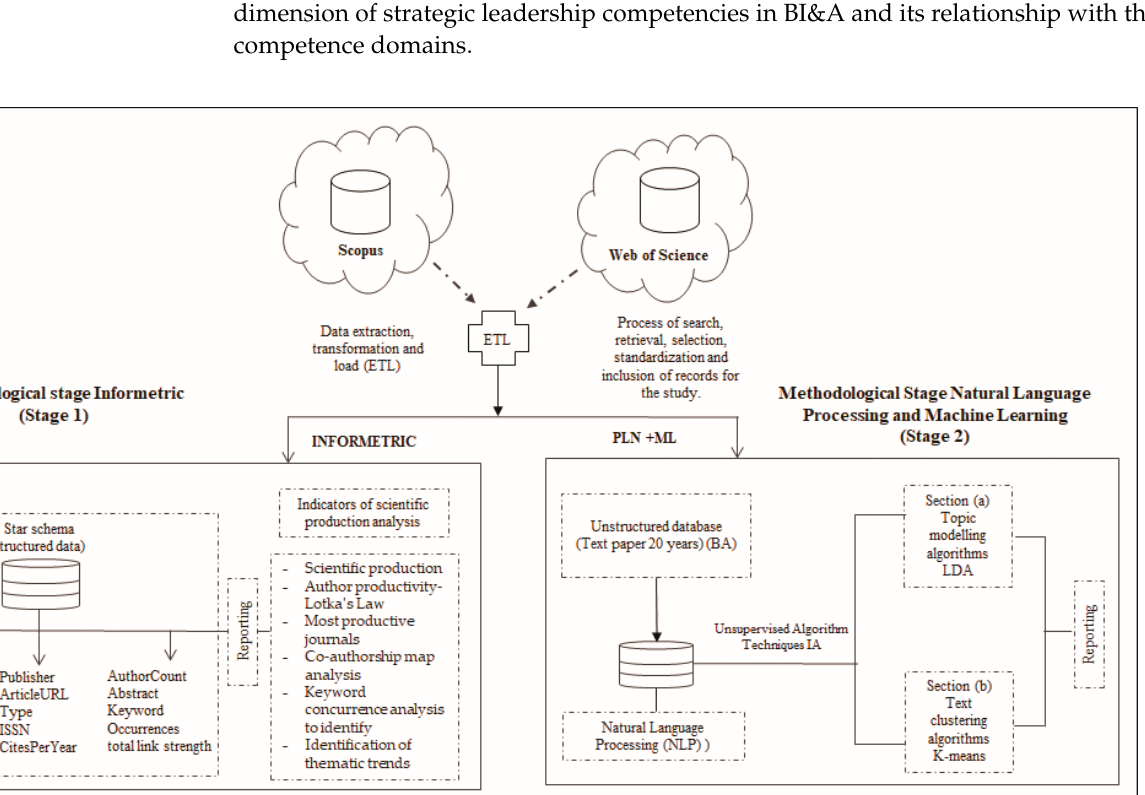
Table 3. Advanced search equation for each bibliographic database. Web of Science Scopus TS = (“business intelligence” AND (analyti- cal OR strategic OR analysis OR descriptive OR predictive OR prescriptive OR competi- tive OR “Analytics 1.0” OR “Analytics 2.0” OR “Analytics 3.0” OR “Analytics 4.0”) AND (Leadership OR Models OR Competenc TITLE-ABS-KEY (“business intelligence” AND (analytical OR strategic OR analysis OR descrip- tive OR predictive OR prescriptive OR competi- tive OR “Analytics 1.0” OR “Analytics 2.0” OR “Analytics 3.0” OR “Analytics 4.0”) AND (lead-